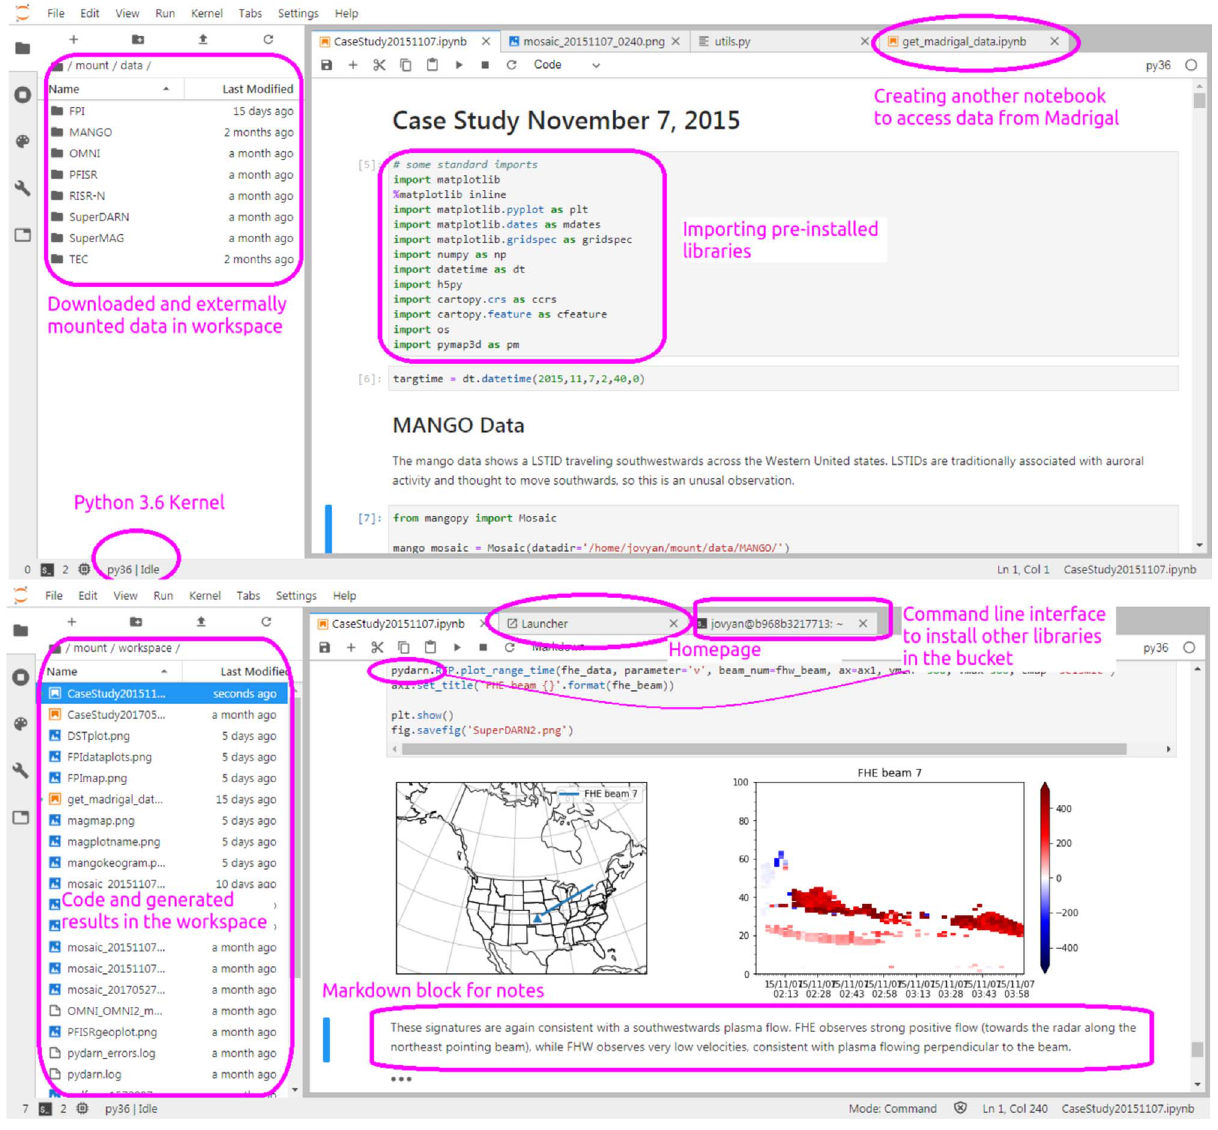
Fig. 3. Annotated screenshots from JupyterLab interface in Resen showing different components. The top panel shows the beginning of the case study notebook with data and importing pre-installed libraries. The bottom panel shows different functionalities of JupyterLab interface, where one can install other libraries like pydarn in the Resen